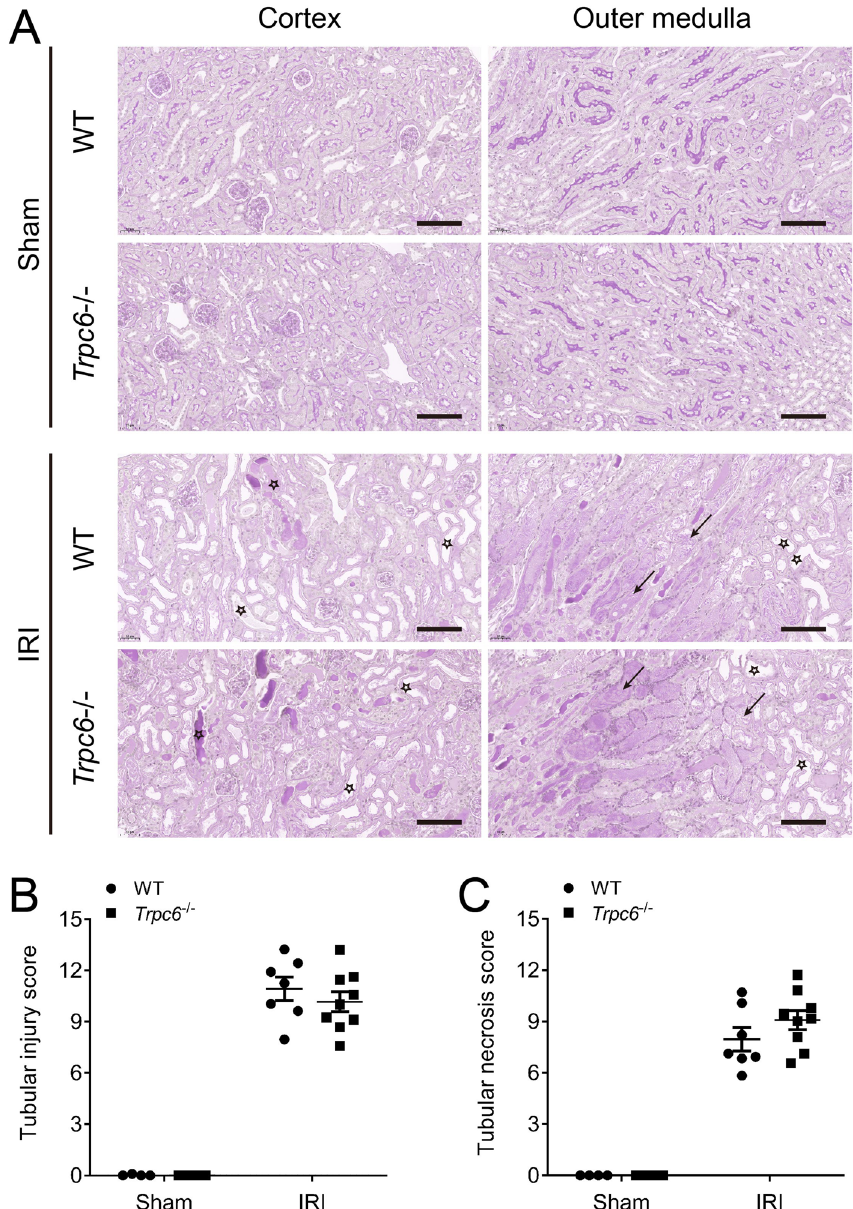
Figure 2. Effect of Trpc6 deficiency on kidney histopathology after renal IRI–induced AKI. ( A ) Representative cortical or outer medullary images of IRI-injured kidneys isolated from Trpc6 −/− and WT mice (magnification: 200 ×). Kidneys sections were stained with periodic acid-Schiff staining (PAS). Arrows indicate tubular necrosis. Stars indicate tubular injury. Scale bars are 100 µm. ( B ) Semi-quantification of cortical tubular injury. ( C ) Semi- quantification of outer medullary tubular necrosis. Data expressed as means ± SEM (Sham WT and Trpc6 −/− n = 4 each, IRI WT n = 7, and Trpc6 −/− n = 9, respectively). Two-way ANOVA followed by Sidak’s multiple comparisons post hoc